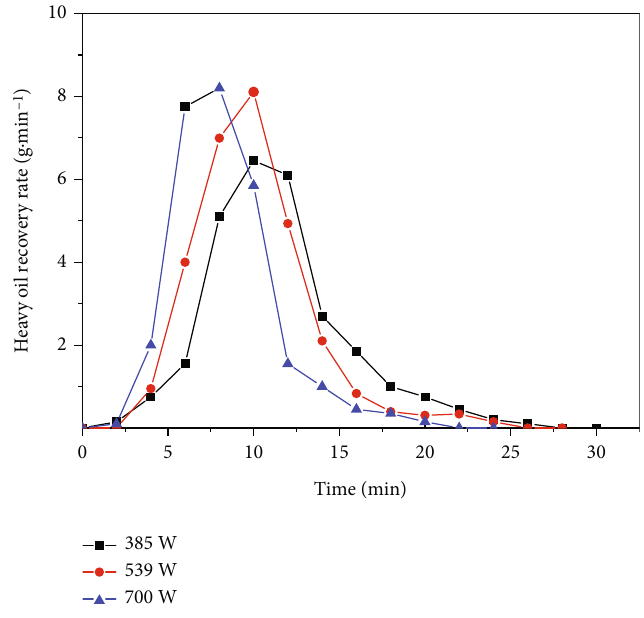
Figure 17: The experimental heavy oil recovery rate curves of each group under di ff erent microwave